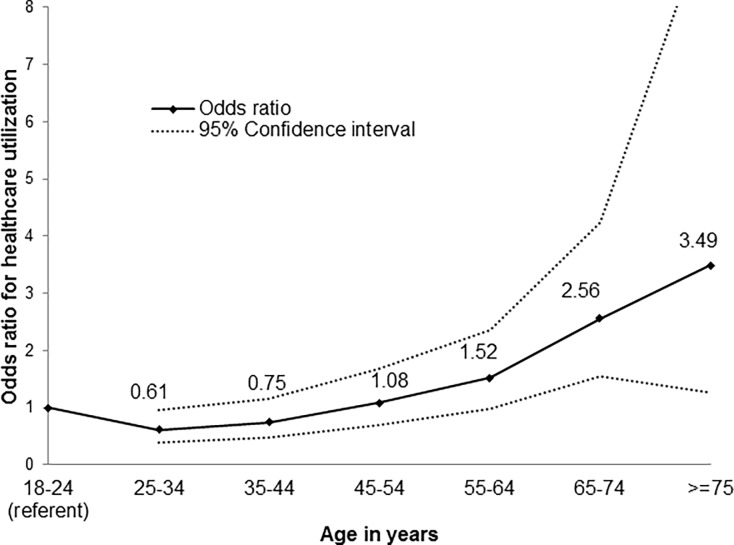
Adjusted odds ratio and 95% CI for healthcare utilization in the past year by age, adjusted for sex, income and chronic health conditions.